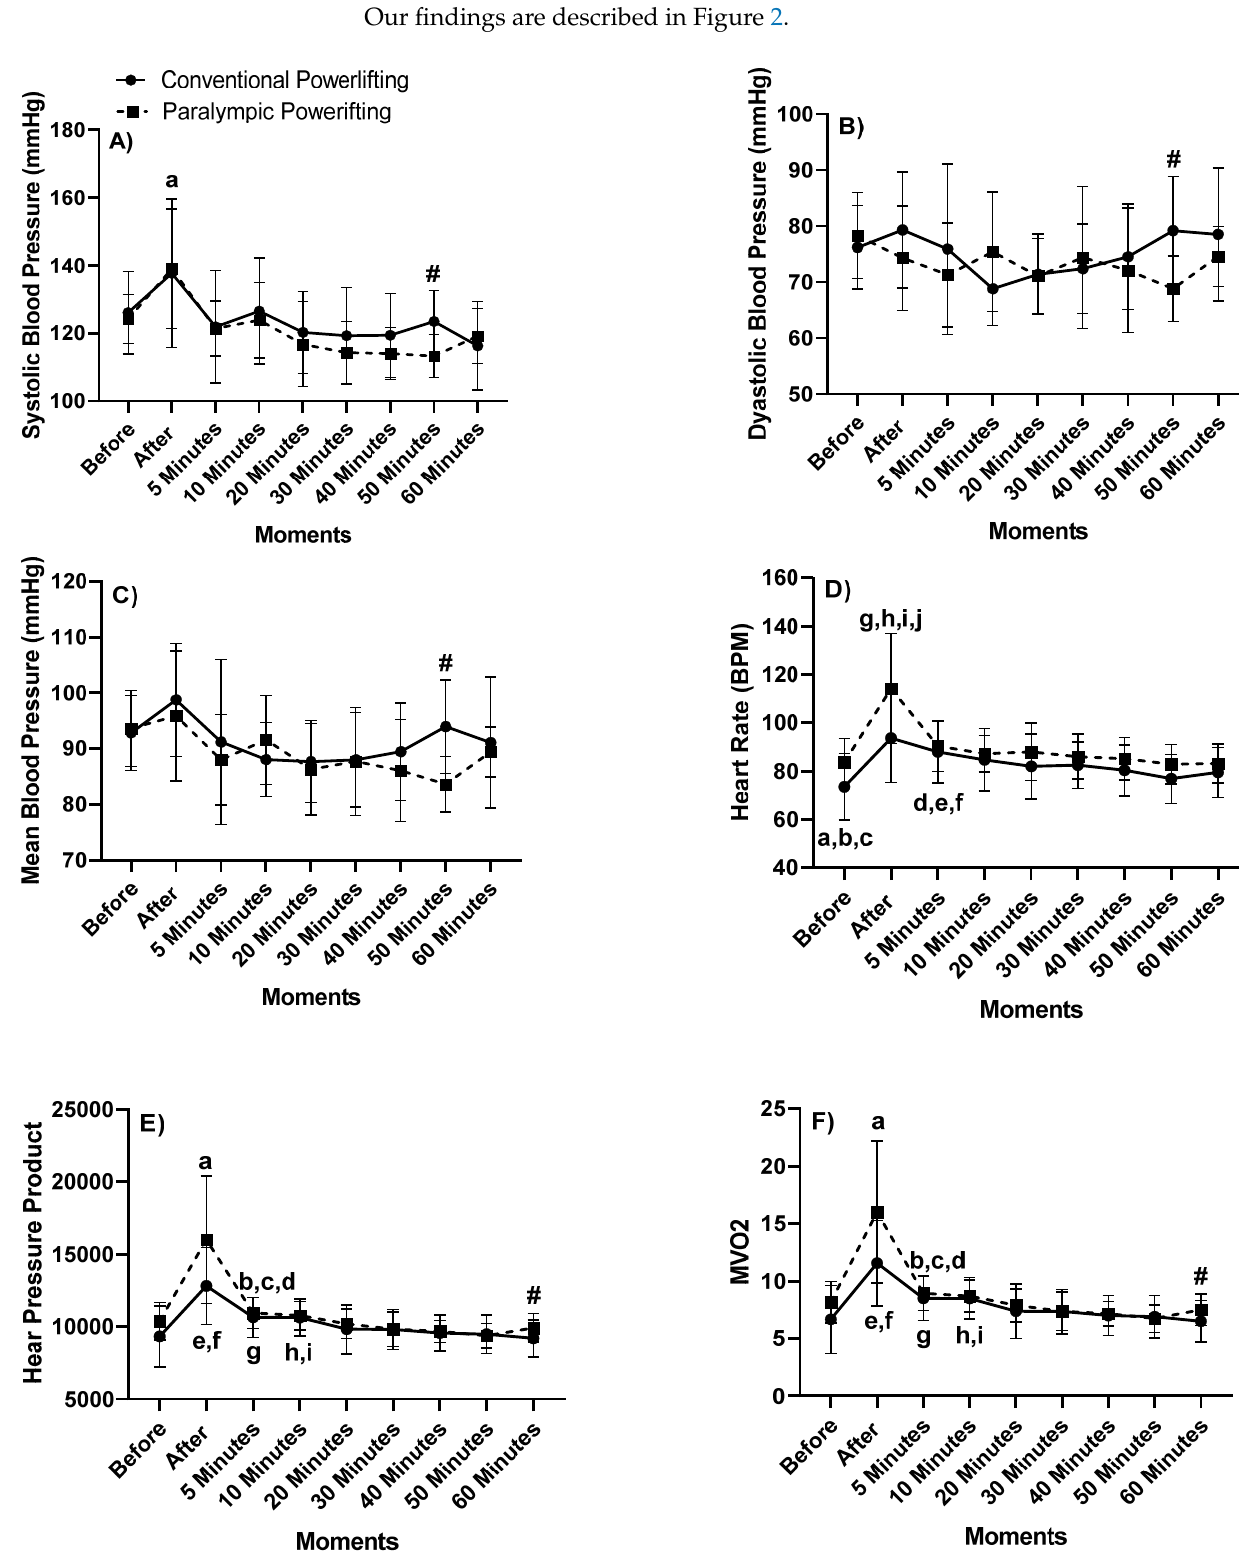
Figure 2. Kinetics of ( A ) systolic blood pressure (SBP), ( B ) diastolic blood pressure (DBP), ( C ) mean blood pressure (MBP), ( D ) heart rate (HR), ( E ) heart pressure product (HPP), and ( F ) MVO 2 . Legend: letters “a–j” indicate intraclass differences, and “#” indicates interclass difference ( p < 0.05).